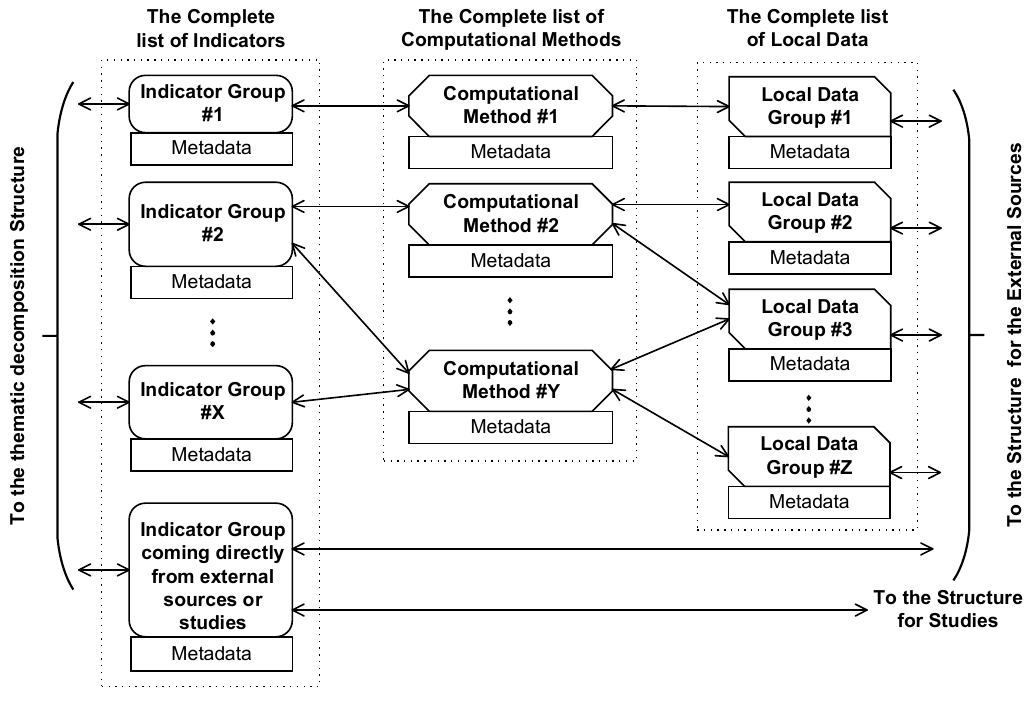
Figure 2. The structure of the meta-database template concerning the indicators, local data and computational methodologies.